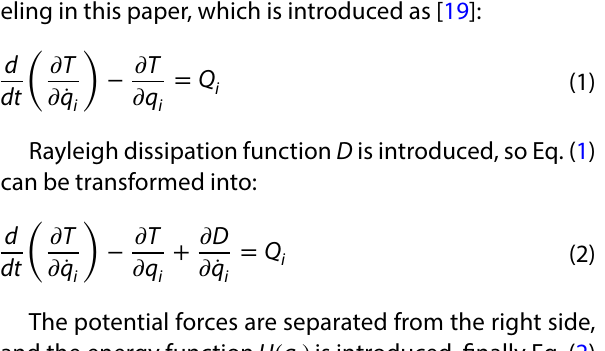
Fig. 2 Schematic diagram of moving path of the cutting